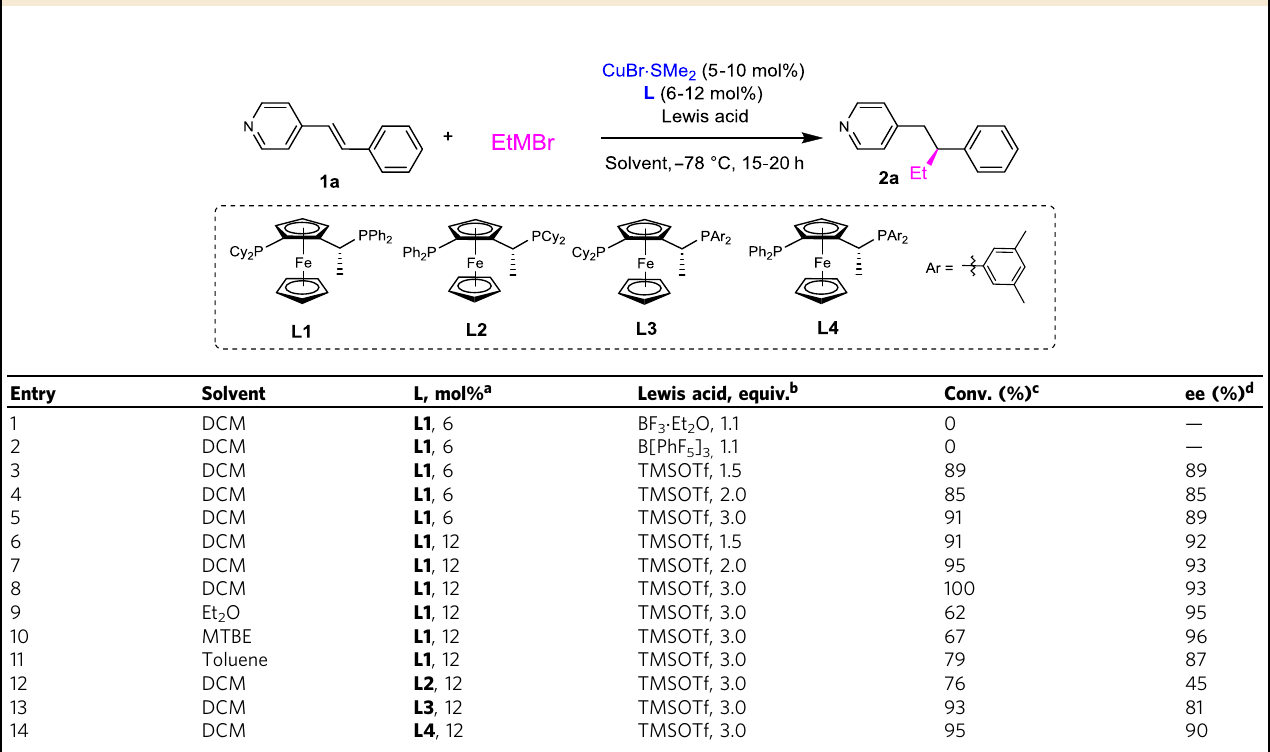
Table 1 Optimisation of reaction conditions